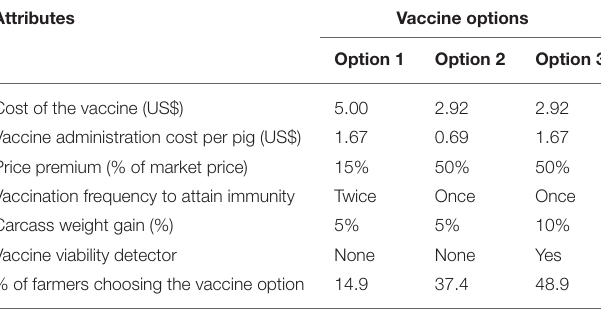
TABLE 8 | T. solium vaccine attribute options selected by a high proportion of pig farmers.